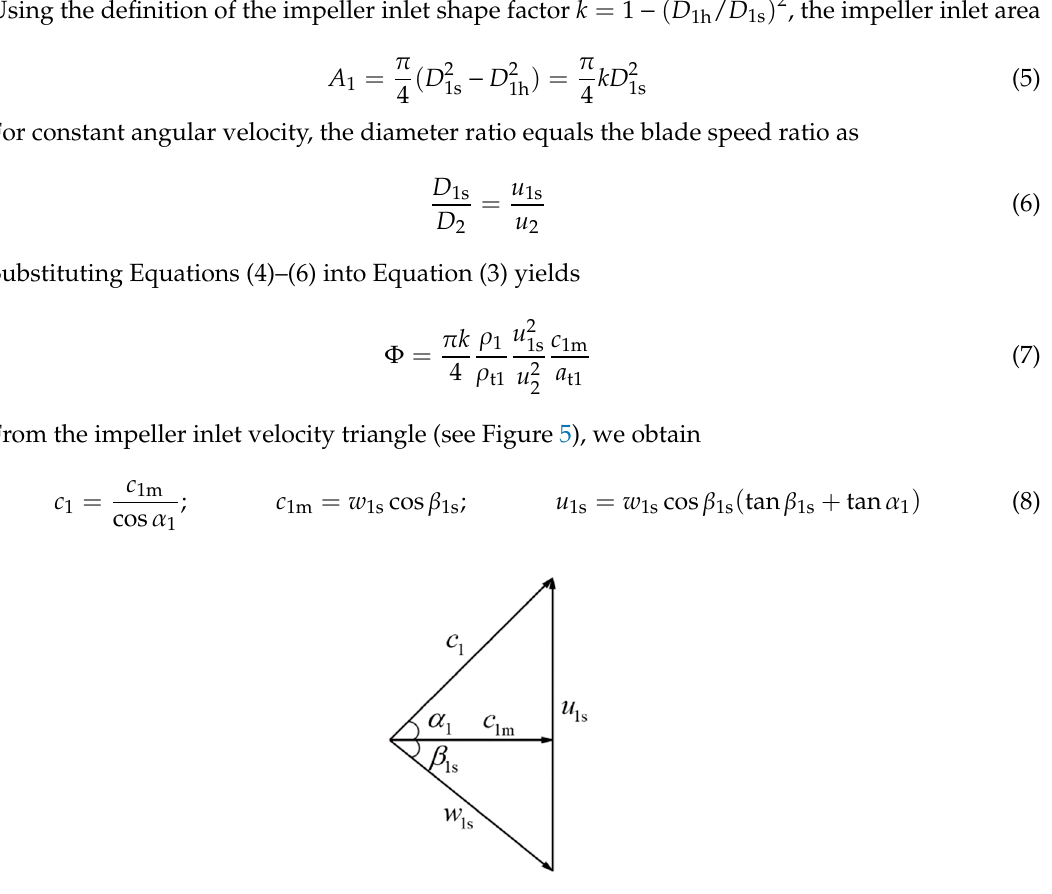
Figure 5. The impeller inlet velocity triangle near the shroud.